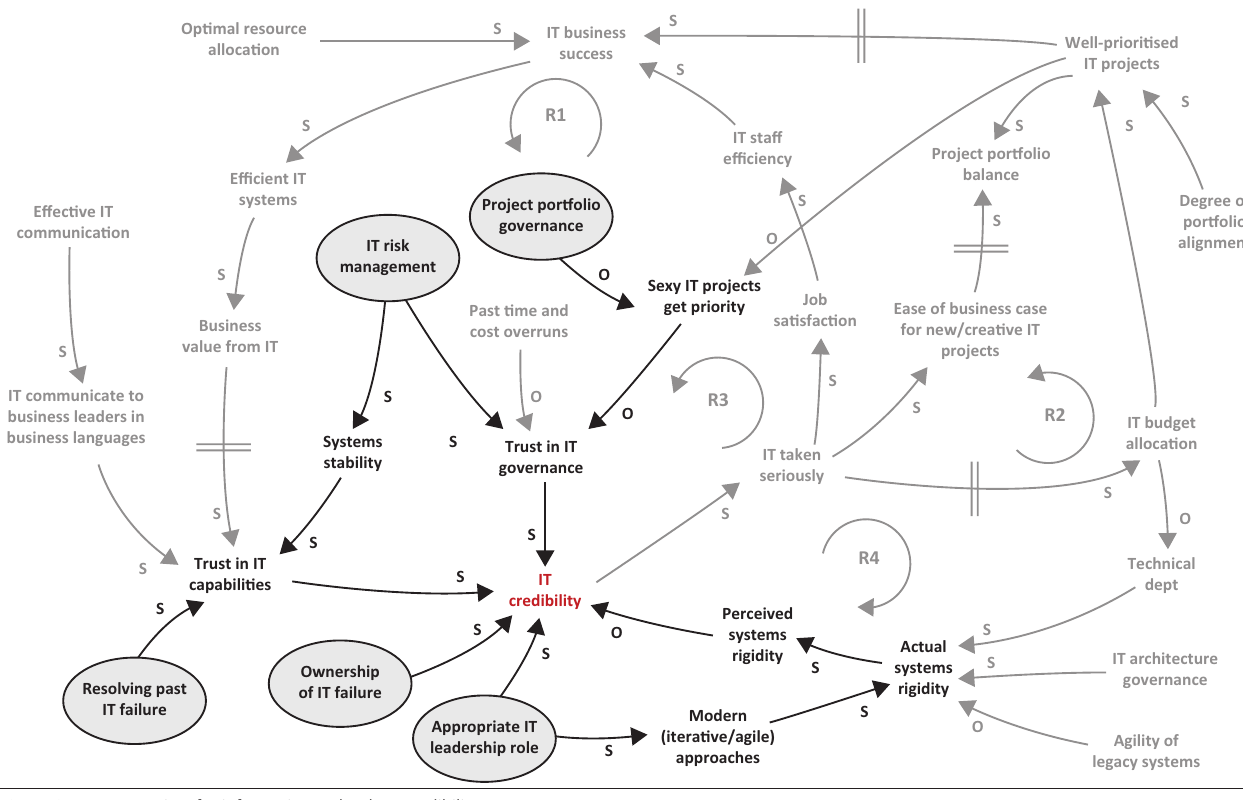
FIGURE 6: Leverage points for information technology